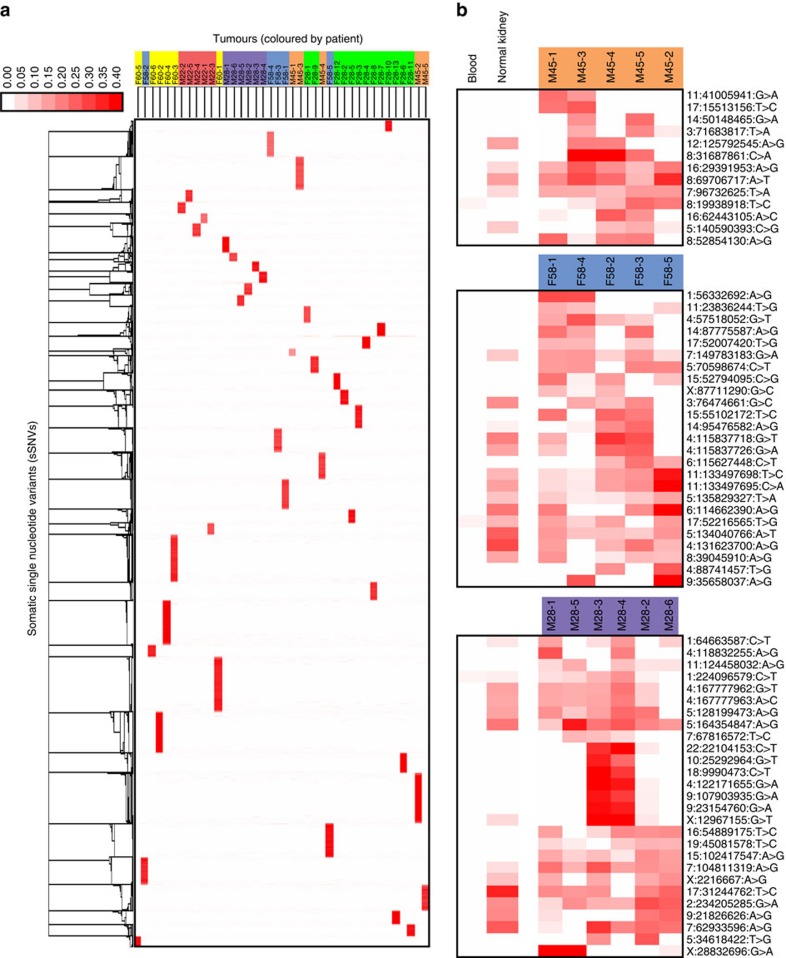
The somatic SNVs revealed that each tumour was independent from the other tumours.(a) 90.2% of the 100,677 variants called had sequencing reads found in only one tumour. Bright red indicates many reads matched the variant, and white indicates no reads matched variant. Lack of overlap in variant sets indicates the tumours are not clonally related. (b) A very small number of variants were called in more than one tumour from each patient. Patients M28purple, M45orange and F58blue had both blood and matched normal kidney tissue. Somatic variant calls were made by comparing tumour to blood; however, the presence of reads in the normal kidney tissue for variants called in more than one tumour is shown. Most of these variants were found in the normal kidney and not in the blood, suggesting they are actually kidney-specific rather than tumour-specific variants. M28-3 and M28-4 share seven variants not called in other tumours. Radiology confirmed these two tumours were adjacent to each other in the kidney.